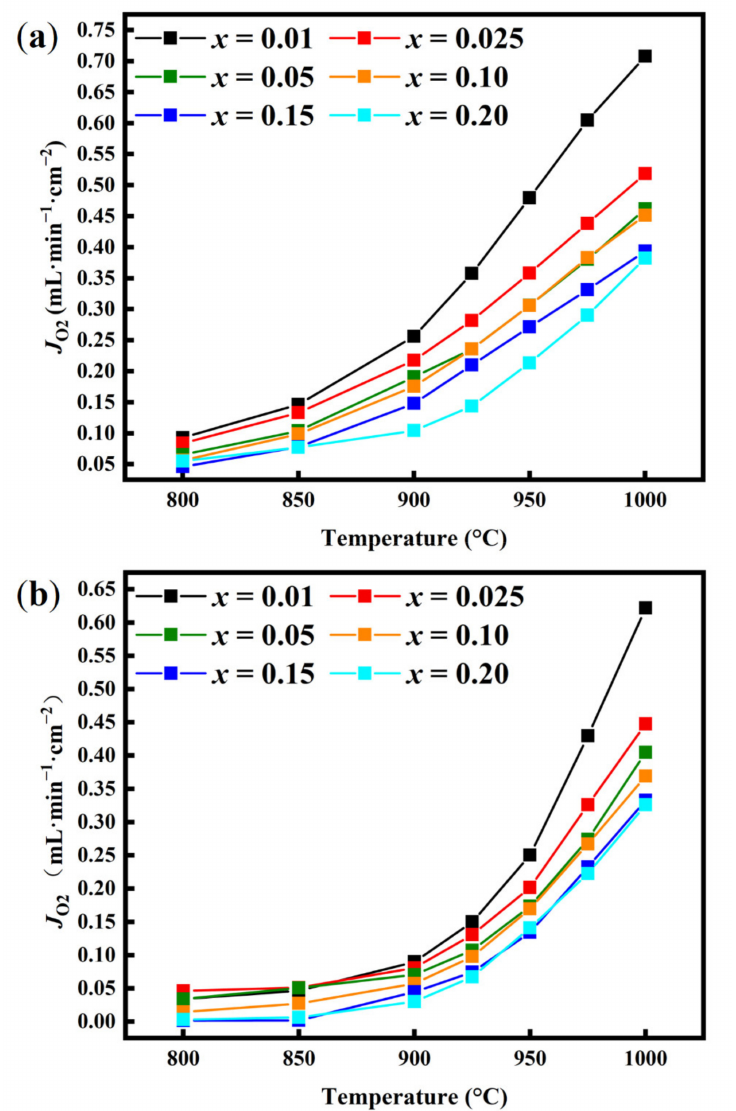
Figure 5. Relationship between oxygen permeation fluxes ( J O2 ) of 60CPO − 40PSF 1 − x B x O OTMs and temperature with different sweep gases. Sweep gas: ( a ) 49 mL · min − 1 He. ( b ) 49 mL · min − 1 CO 2 . Feed gas: 150 mL · min − 1 air. Calibration gas: 1 mL · min − 1 Ne. Thickness of OTMs: 0.6